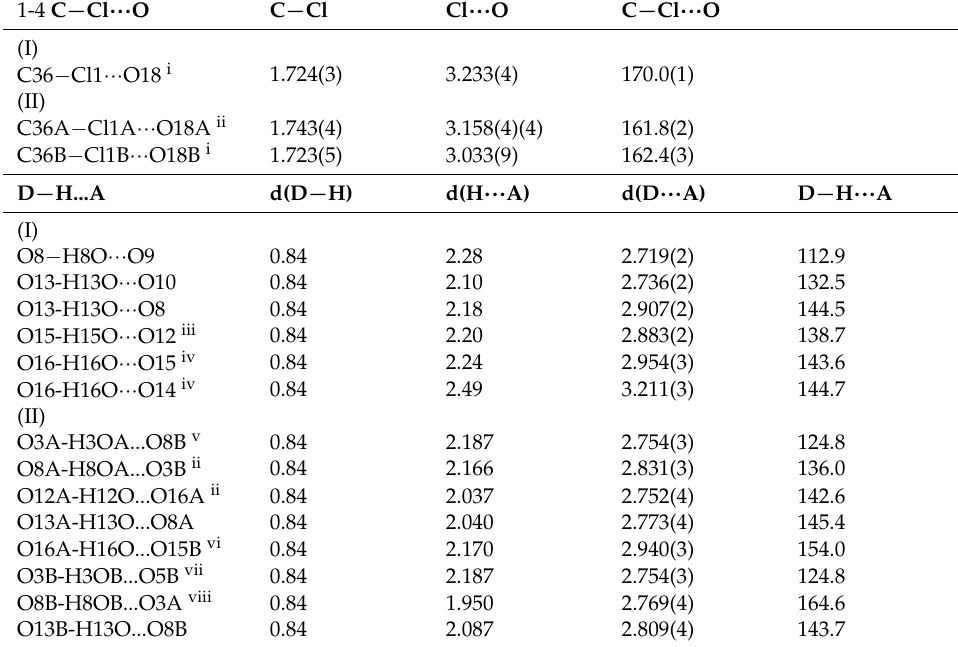
Table 1. Halogen- and hydrogen-bond data [Å , ◦ ] for monoclinic form (I) and triclinic form